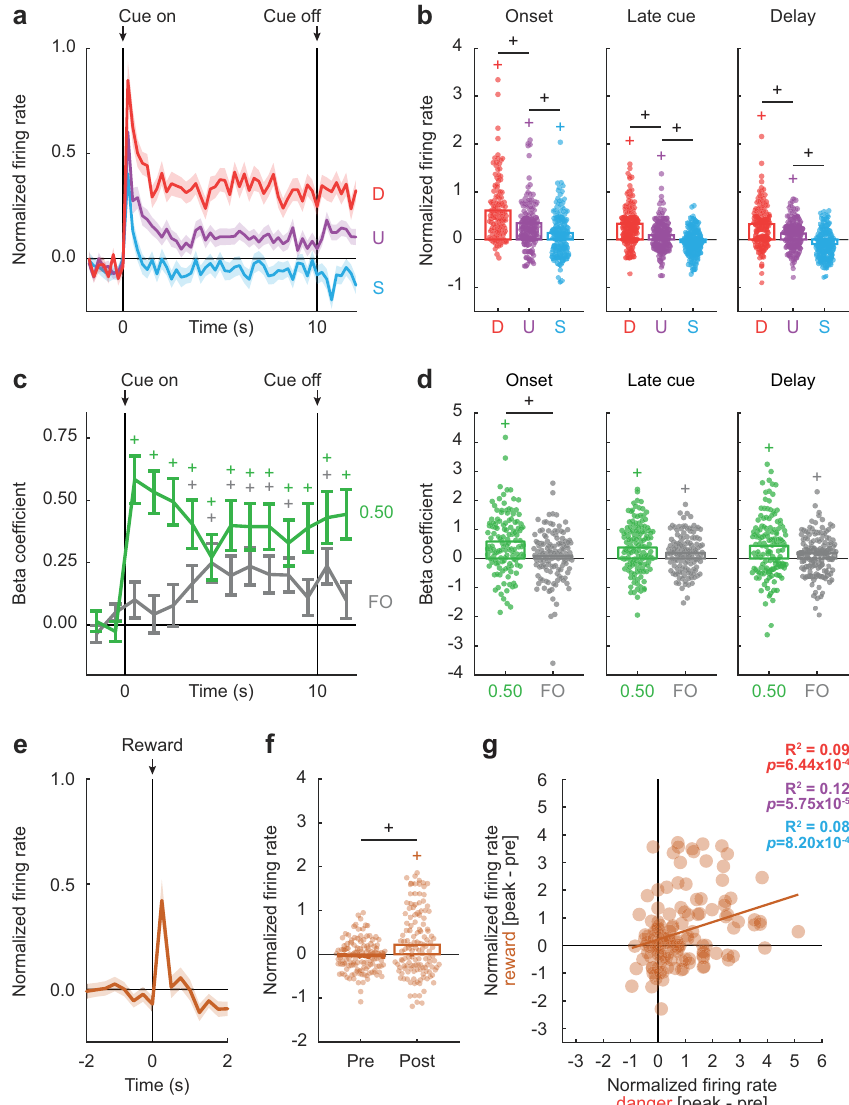
Fig. 6 Differential cue fi ring by cue-excited neurons re fl ects relative threat and fear output. a Mean normalized fi ring rate to danger (D, red), uncertainty (U, purple), and safety (S, blue) is shown from 2 s prior to cue onset to 2 s following cue offset for the cue-excited population ( n = 131). Cue onset and offset are indicated by vertical black lines. b Mean (bar) and individual (data points), normalized fi ring rate for cue-excited neurons during the fi rst 1 s cue interval (onset, left), the last 5 s cue interval (late cue, middle), and 2 s following cue offset (delay, right) are shown for each cue (D, danger, red; U, uncertainty, purple; S, safety, blue). + 95% bootstrap con fi dence interval for differential cue fi ring rate does not contain zero. + 95% bootstrap con fi dence interval for normalized fi ring rate does not contain zero (colored plus signs). c Mean ± SEM beta coef fi cients are shown for each regressor (0.50, assignment, green; FO, fear output, gray), from 2 s prior to cue onset to 2 s following cue offset in 1 s intervals, for the cue-excited population. Cue onset and offset are indicated by vertical black lines. d Mean (bar) and individual (data points), beta coef fi cient for each regressor (0.50, assignment, green; FO, fear output, gray) for cue-excited neurons. + 95% bootstrap con fi dence interval for differential beta coef fi cient does not contain zero. + 95% bootstrap con fi dence interval for beta coef fi cient does not contain zero (colored plus signs). e Mean normalized fi ring rate to reward is shown 2 s prior to and 2 s after the reward delivery (advancement of pellet dispenser) for the cue-excited population (maroon). Reward delivery is indicated by vertical black line. f Mean (bar) and individual (data points), normalized fi ring rate for cue-excited neurons are shown during 500 ms interval prior (pre) to and 500 ms interval after (post) the reward delivery. + 95% bootstrap con fi dence interval for differential fi ring rate does not contain zero. + 95% bootstrap con fi dence interval for fi ring rate does not contain zero (maroon plus sign). g Mean normalized fi ring rate to reward (250 ms prior to reward delivery to 250 ms following reward delivery, [peak - pre]) vs. danger (the fi rst 250 ms of cue, [peak - pre], red) is plotted for cue-excited neurons. Trendline, the square of the Pearson correlation coef fi cient ( R 2 ) and associated p value ( p ) are shown. R 2 and p for uncertainty (purple) and safety (blue) are signaled salience. In support of salience signaling, cue-excited 9.32 × 10 − 16 , η p 2 = 0.05, op = 1.00). Single-unit fi ring prior to neurons increased fi ring to reward (Fig. 6e). Repeated measures reward delivery hovered around zero. Firing increases following ANOVA for normalized fi ring rate [factor: interval (16 total: 250 reward delivery exceeded zero ( M = 0.22, 95% CI [0.07, 0.35]), ms bins from 2 s prior → 2 s following advancement of pellet and also exceeded pre-reward fi ring ( M = 0.26, 95% CI [0.10, dispenser)] revealed a main effect of interval ( F 15,1920 = 7.24, p = 0.41]; Fig. 6f). Further supporting salience signaling, the